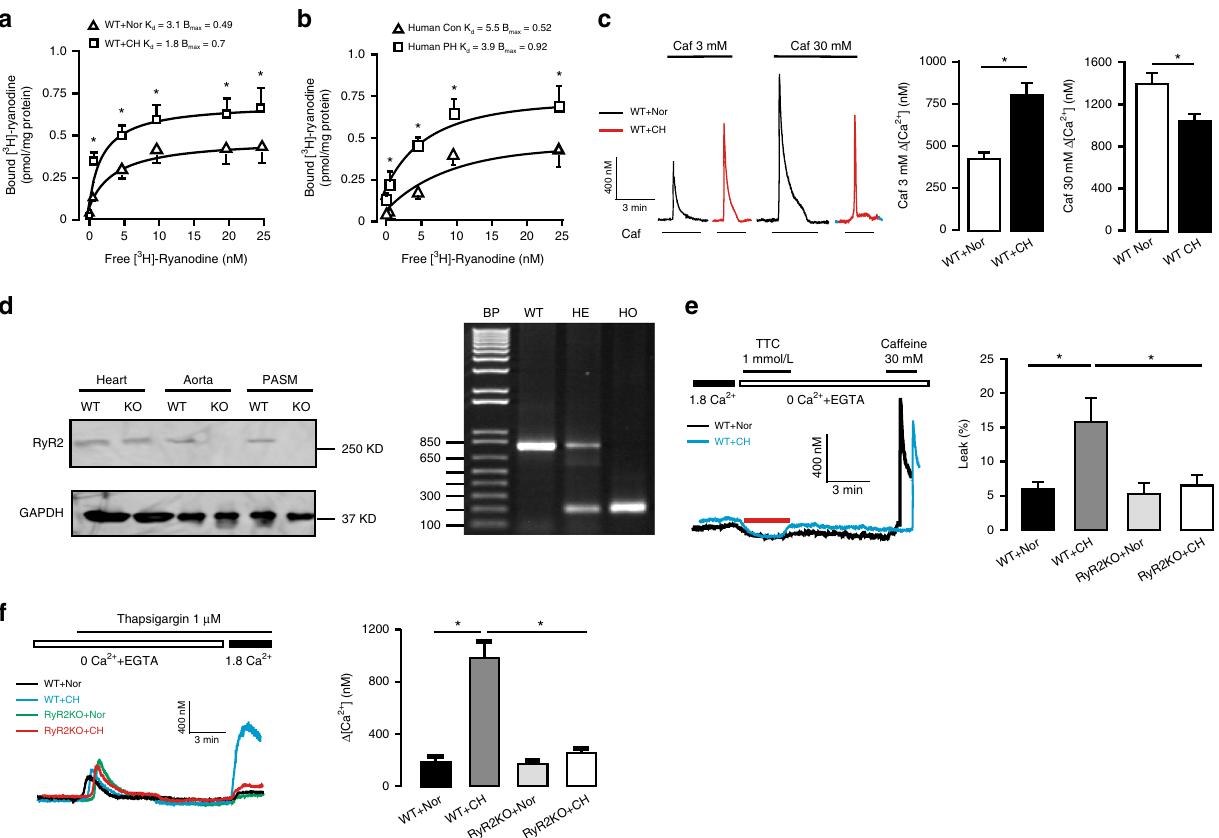
Fig. 1 Deletion of RyR2 gene prevents CH-induced calcium signal over-activation. a [ 3 H]-ryanodine binding assays are conducted from wild-type (WT) mice pulmonary arteries (PAs) pretreated with normoxia (Nor) and chronic hypoxia (CH) ( n = 5 independent studies, 5 mice per study). b Human PAs samples with pulmonary hypertension (PH) and age-matched non-PH human PAs (Con) are used to evaluate RyRs activity by [ 3 H]-ryanodine binding assays ( n = 3 independent studies). c Recording of medium (3 mM) and maximal (30 mM) concentration caffeine (Caf)-induced PASMC Ca 2 + release. Bar graph summary of medium (3 mM) and maximal (30 mM) concentration Caf-induced Ca 2 + release in WT pulmonary arterial smooth muscle cells (PASMC) after exposure to 3 weeks CH ( n = 7 independent studies, 95 cells per study). d Representative western blot and PCR of RyR2 expression from RyR2 gene knockout (KO) mice. Tissue are harvested from heart, aorta and PASM ( n = 3 independent studies, 4 mice per study). e Representative [Ca 2 + ] i tracing from Nor and CH PASMC loaded by fura-2/AM switch to 0 Ca 2 + physiological saline solution (PSS) and 1 mmol/L tetracaine (TTC) to block RyR2. Sarcoplasmic reticulum (SR) Ca 2 + content is measured by adding 30 mM caffeine. SR Ca 2 + leak ratio is quanti fi ed and normalized to SR Ca 2 + content in WT and RyR2 KO mice at Nor and CH condition ( n = 4 independent studies, 50 cells per study). f Fura-2/AM Ca 2 + imaging showing essentially abrogation of store-operated calcium entry (SOCE) activated by thapsigargin (1 μ M) in PASMC from RyR2KO mice and statistical results of Ca 2 + in fl ux peak ( n = 4 independent studies, 60 cells per study). Data are expressed as mean ± standard error. (* P < 0.05, using one-way ANOVA test or Student ’ s t